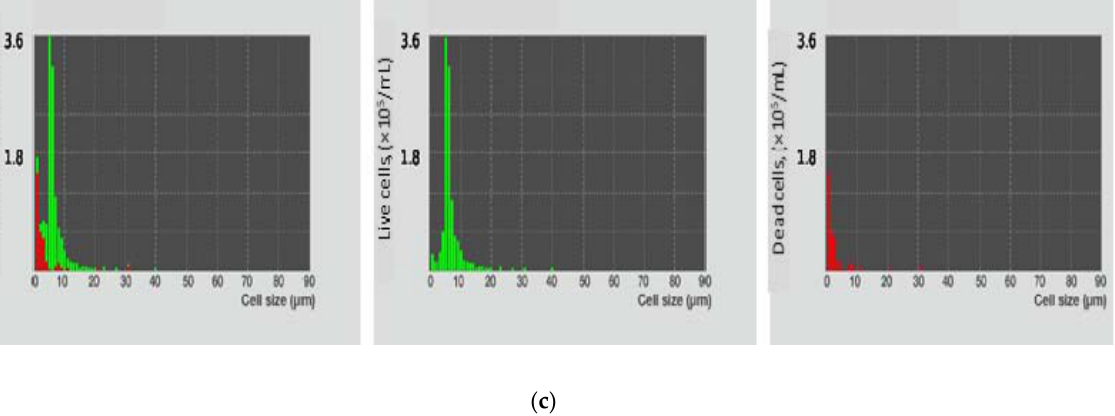
Figure 2. Yeast fermentation activity ( a ) and non ‐ viable cell count ( b ) during ultrasound treatment; non ‐ viable cell count ( c ) at 15 W/m 2 and a contact time of 20 min (LUNA ‐ II YF™ research protocol) (green ‐ live cells, red ‐ dead cells). In panels ( a ) and ( b ), the values with a statistically significant difference ≤ 0.05 are shown.